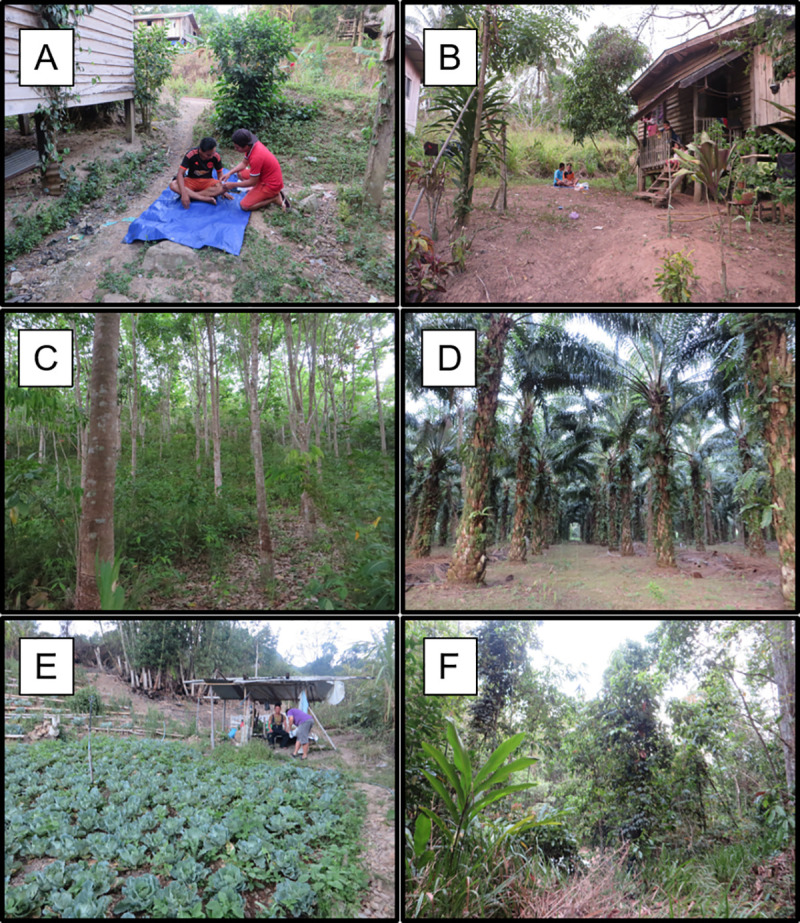
Photos showing examples of typical peri-domestic (A, B), farm (C = rubber, D = palm, E = cabbage) and forest (F) habitats where mosquito collections were conducted in this study.